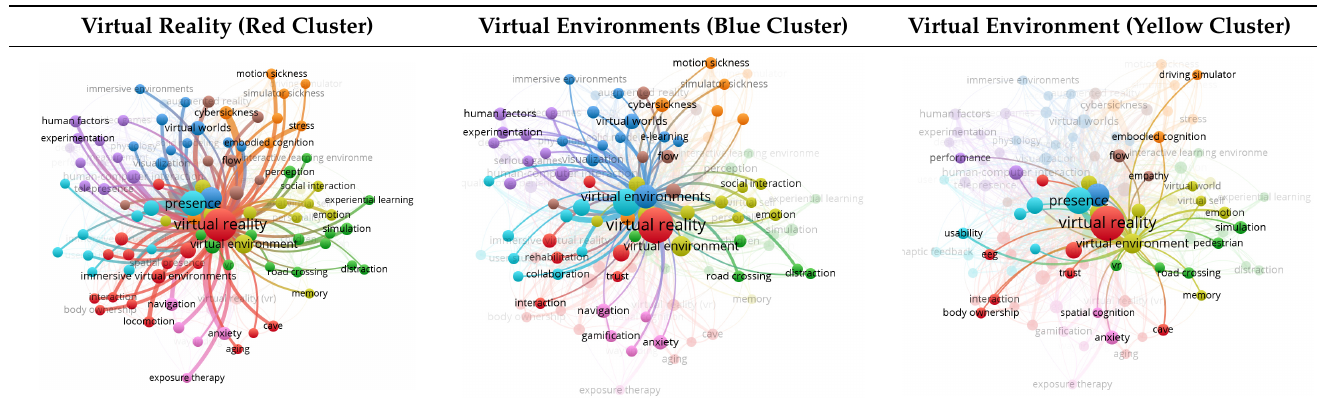
Figure 14. Virtual reality—embodiment–presence continuum.